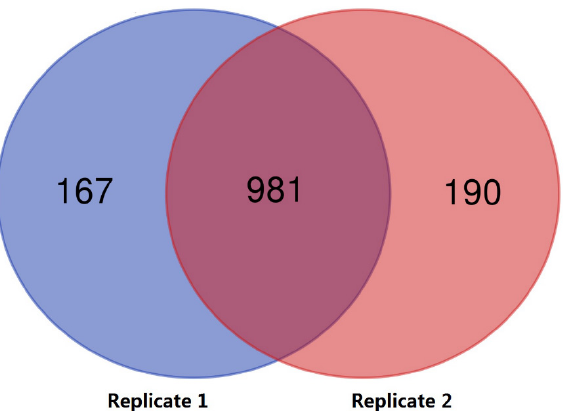
Figure 2. Venn diagram of sperm proteomic replicates. Replicate 1 detected 1148 proteins (blue), Replicates 2 detected 1171 proteins (red), and 981 proteins (purple) were replicated twice.